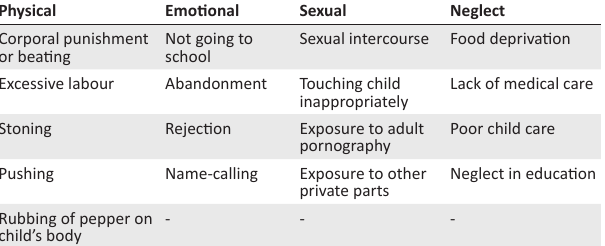
TABLE 4: Types of abuse experienced by children and young adults with